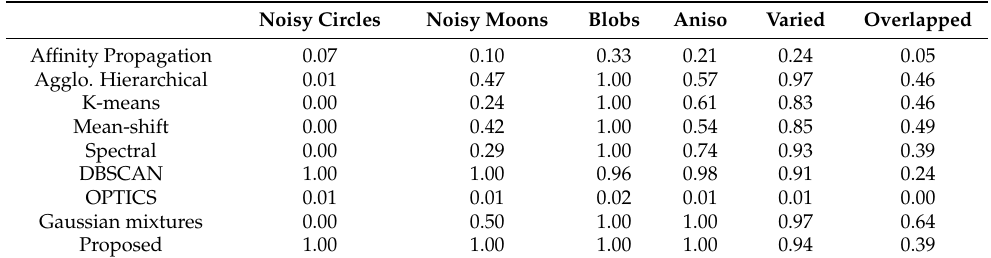
Table 3. The ARI of affinity propagation, agglomerative hierarchical, k-means, mean-shift, spectral, DBSCAN, OPTICS, Gaussian mixtures, and the proposed clustering methods on noisy circles, noisy moons, blobs, anisotropic, varying variance, and overlapping datasets.